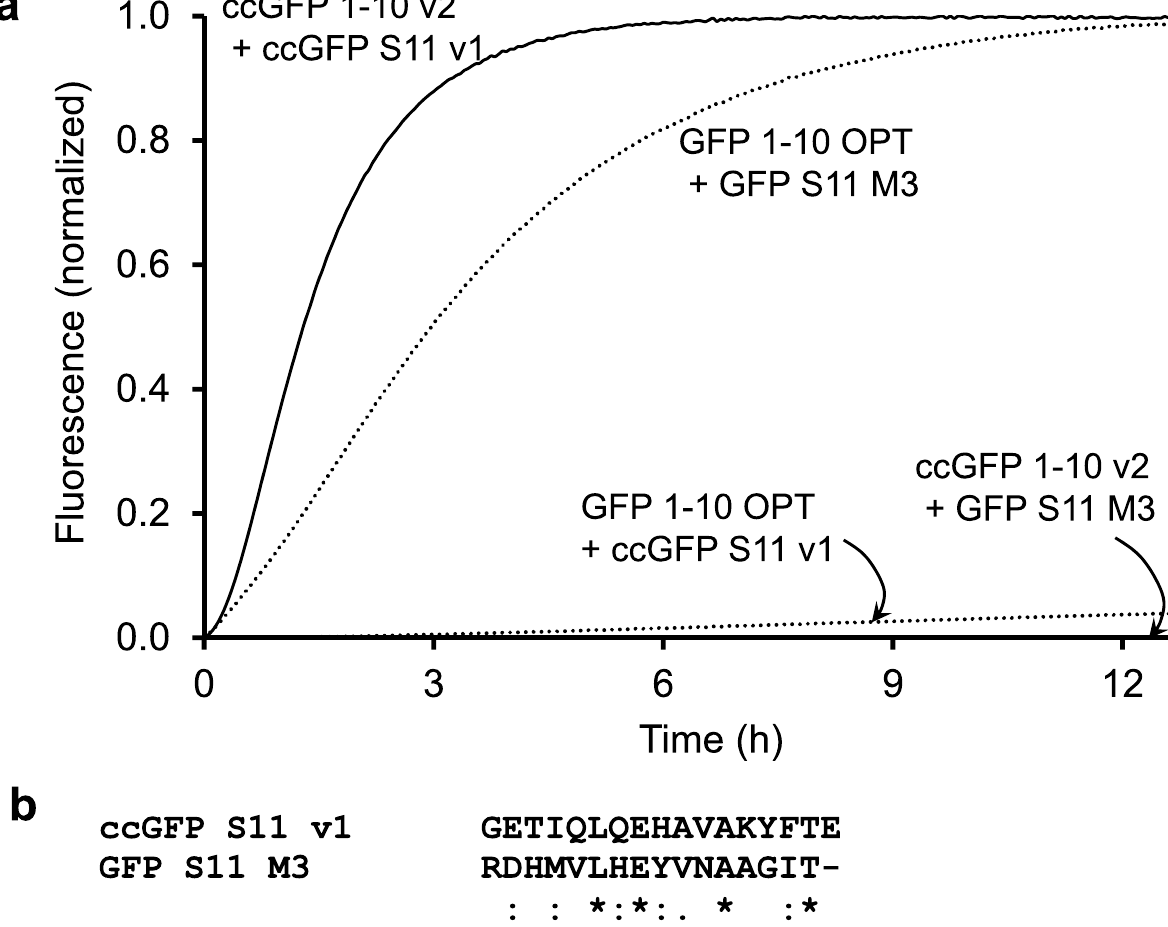
Figure 5. ( a ) Normalized progress curves for complementation of cognate and non-cognate ccGFP and GFP fragments. Rapid complementation of cognate fragments (upper curves). ccGFP 1–10 v2 and SR-ccGFP S11 v1 (upper solid line); GFP 1–10 OPT and SR-GFP S11 M3 (upper dotted line). GFP fragments are from the original split GFP 1 derived from A. victoria . Weak complementation between non-cognate fragments (bottom curves). Complementation between ccGFP 1–10 v2 and its non-cognate fragment SR-S11 M3 is not detectable and the trace is at the baseline (bottom solid line). Complementation of GFP 1–10 OPT with the non-cognate fragment ccGFP S11 v1 (lower dotted line) is ~ 4% of the final value for the cognate GFP S11 fragment (upper dotted line). Complementation was initiated by mixing 800 pmol of each 1–10 fragment with 50 pmol of S11 fragment in 200 µl reaction wells. ( b ) Amino acid sequence alignment showing sequences of ccGFP S11 v1 and GFP S11